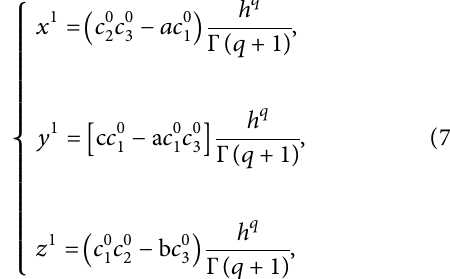
Figure 3: The chaos diagram of the largest Lyapunov exponents with z